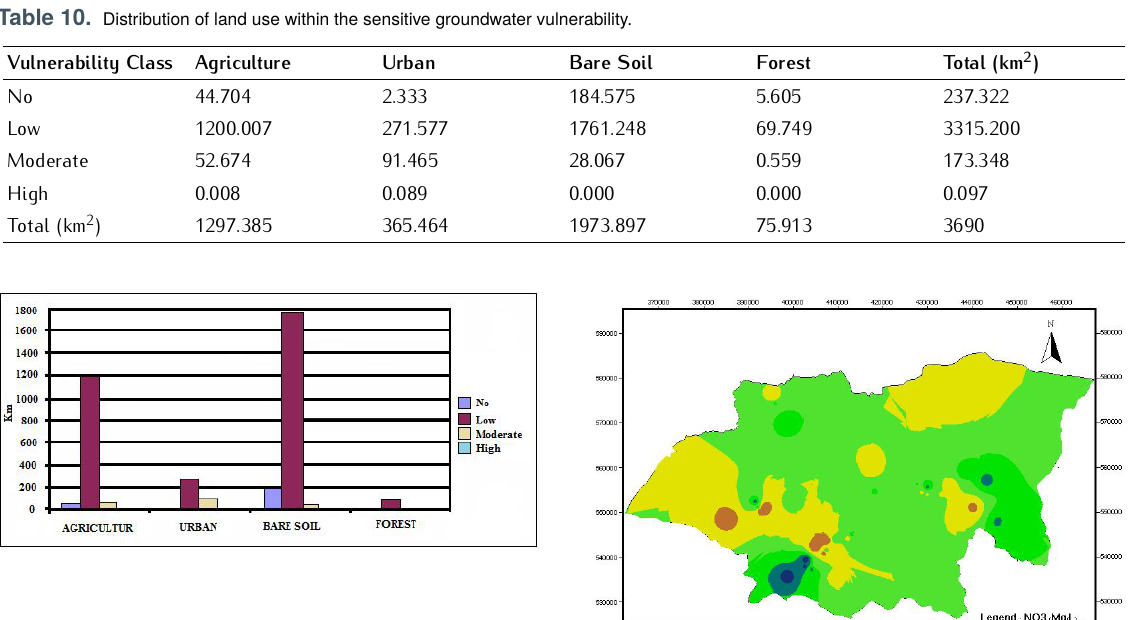
Figure 14. Histogram showing distribution of land use with sensitive groundwater vulnerability.